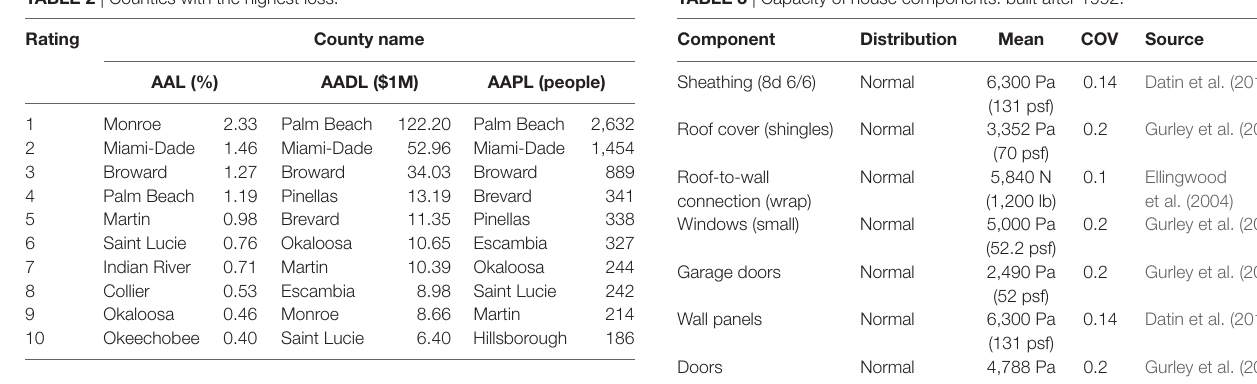
TaBle 2 | Counties with the highest loss. TaBle 3 | Capacity of house components: built after